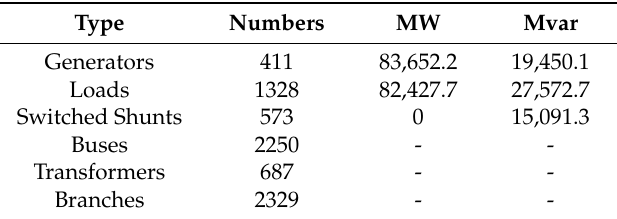
Table 3. Information of the Korean power system for